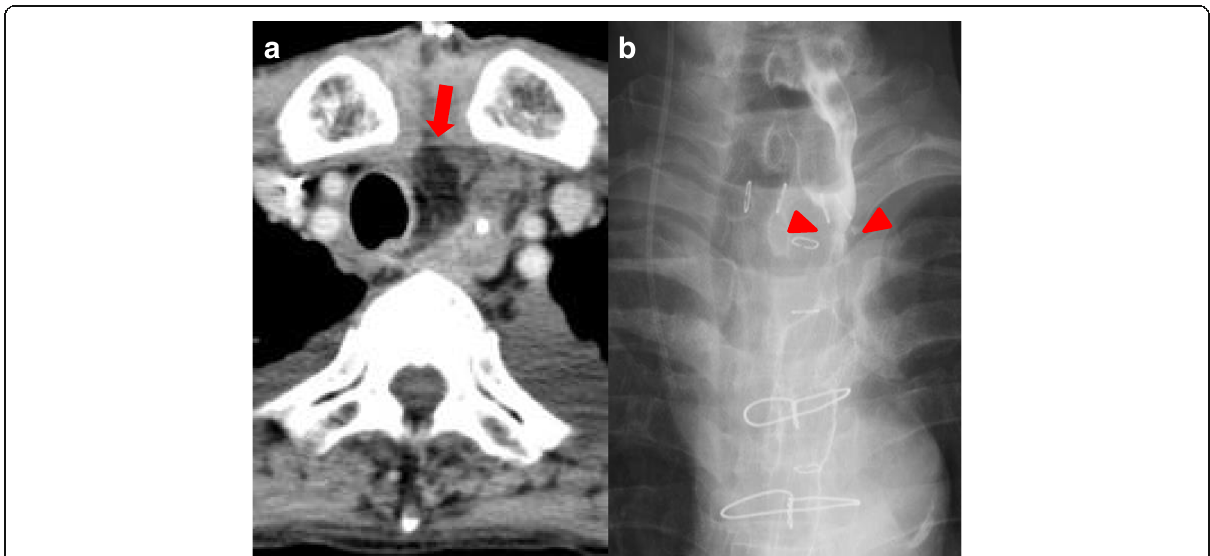
Fig. 4 The findings after surgery for tracheoesophageal fistula (TEF). a CT image. The arrow indicates the thymus pedicle flap. b Esophagography shows no leakage on the esophagogastric anastomotic site